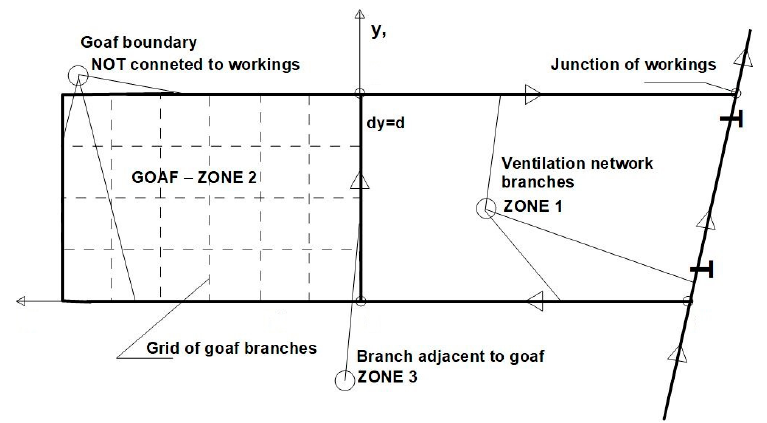
Figure 1. The diagram of the longwall area with goafs in the VentZroby software, [9].